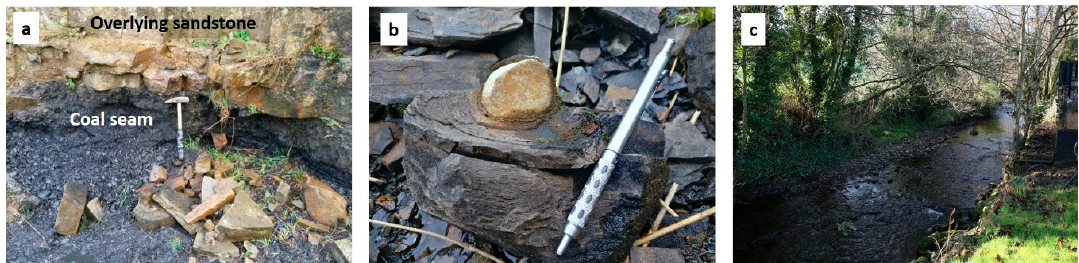
Figure 4. Sampling locations in the Castlecomer area of the Leinster Coalfield, County Kilkenny. (a) In situ coal seam and loose spoil at the abandoned Bilboa Quarry, Castlecomer. (b) Sideritic nodule hosted within coal (Bilboa Quarry). (c) The River Dinin, which flows through the former coal mining Castlecomer area, which hosts mineralised coal and siderite samples.